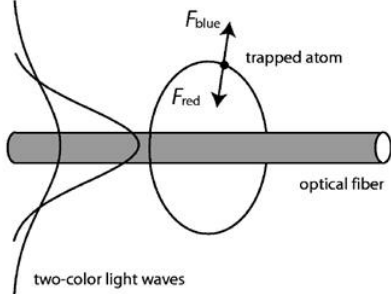
Figure 11. Schematic representation of atom trapping and guiding around an optical nanofiber using two-color evanescent light fields. Reprinted with permission from [83]. Copyright 2004 American Physical